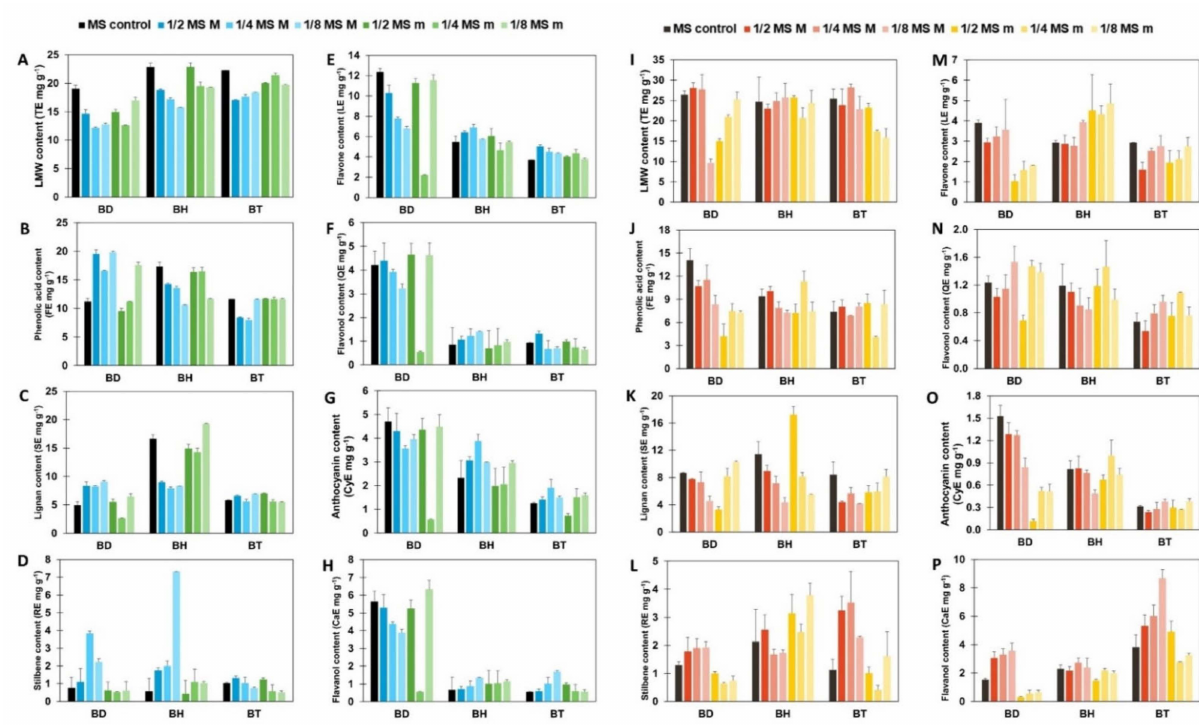
Figure 1. Semi-quantification of each subfamily of phenolic compounds. All results are expressed in mg g − 1 of equivalents for each reference compound. Vertical bars indicate the standard deviation. ( A – H ): phenolic content of aerial parts. ( I – P ): phenolic content of roots. TE, tyrosol equivalents, for the LMW content; FE, ferulic acid equivalents, for the phenolic acid content; SE, sesamin equivalents, for the lignan content; RE, resveratrol equivalents, for the stilbene content; LE, luteolin equivalents for the flavone content; QE, quercetin equivalents, for the flavonol content; CyE, cyanidin equivalents, for the anthocyanin content; CaE, catechin equivalents, for the flavanol equivalents.